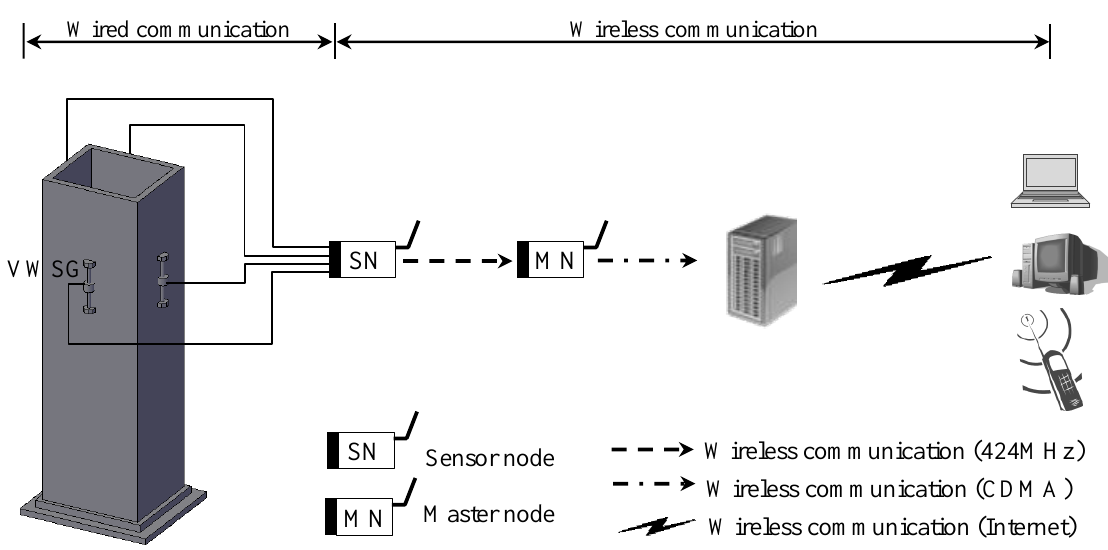
Figure 2. Wireless strain sensing system for the mega-column based on